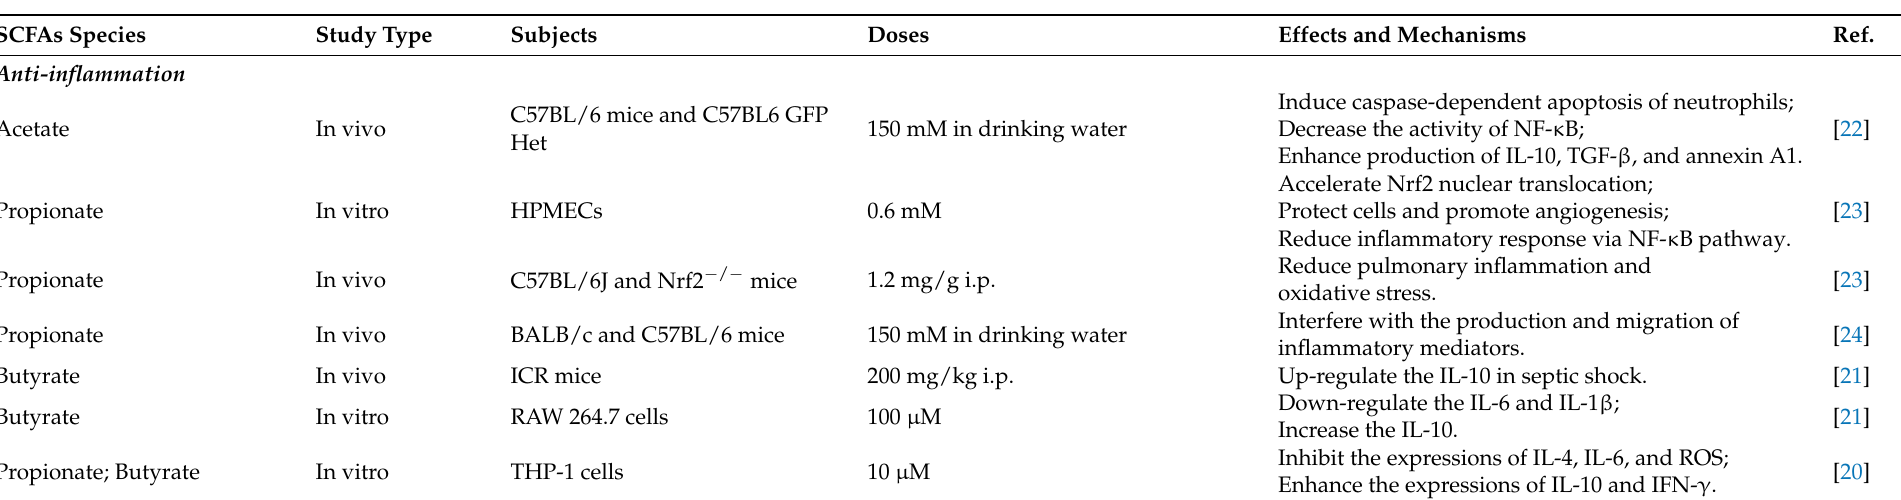
Table 2. Health benefits and molecular mechanisms of SCFAs from preclinical